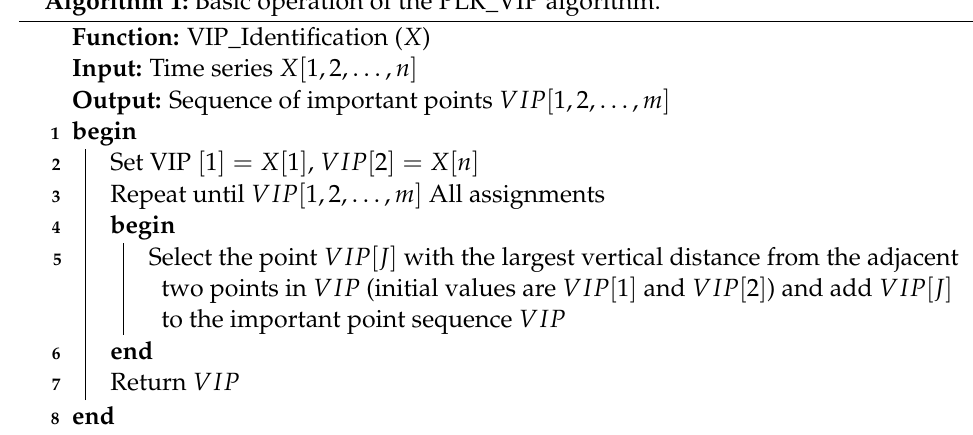
Algorithm 1: Basic operation of the PLR_VIP algorithm.